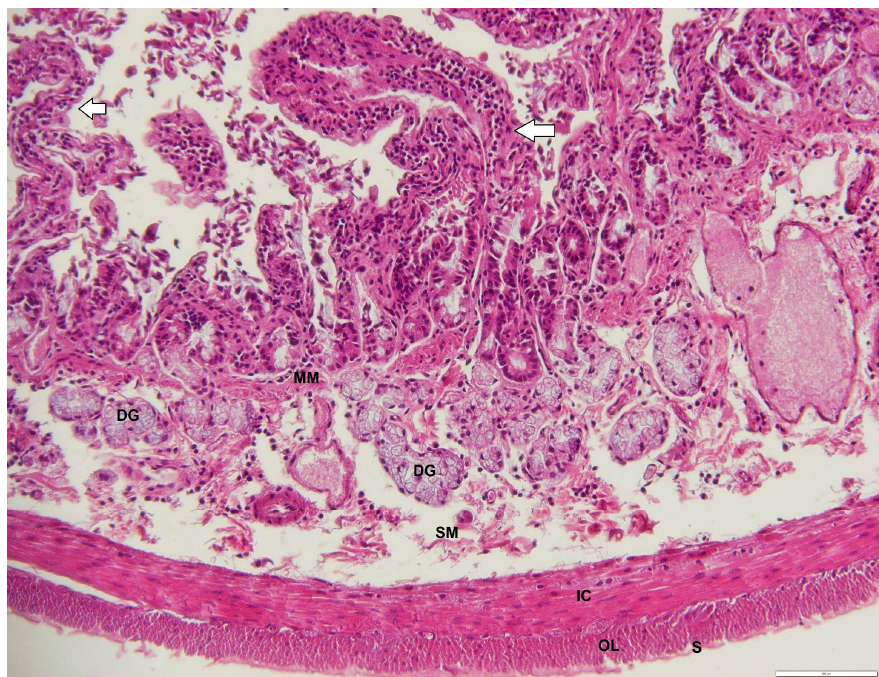
Figure 9. Photomicrograph of a transverse section through the duodenum of an adult male D. leporina , showing villi (arrows). H&Ex200. MM—muscularis mucosa; DG—duodenal glands; SM— submucosa; IC—inner circular layer; OL—outer longitudinal layer; S—serosa.